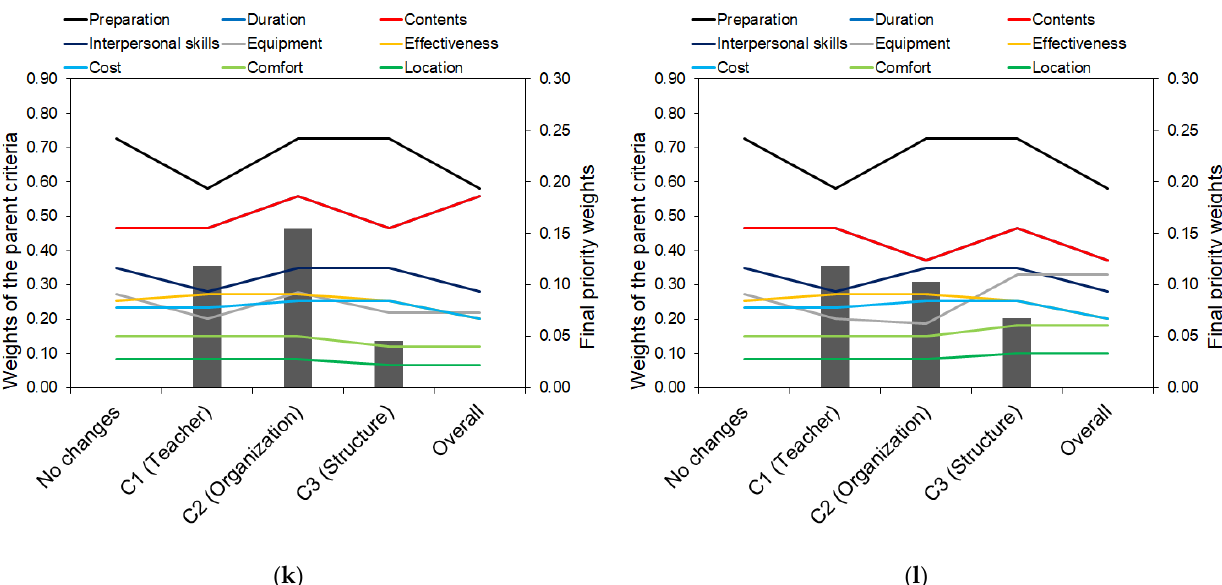
Figure 5. Simulated scenarios (according to Table 9) in the AHP sensitivity analysis: ( a ) scenario 1; ( b ) scenario 2; ( c ) scenario 3; ( d ) scenario 4; ( e ) scenario 5; ( f ) scenario 6; ( g ) scenario 7; ( h ) scenario 8; ( i ) scenario 9; ( j ) scenario 10; ( k ) scenario 11; ( l ) scenario 12. Weights of the parent criteria are represented as gray histograms and refer to the primary y -axis, while dynamical changes in the final priority weights are represented as colored straight lines and refer to the secondary y -axis. The x -axis represents five cases: original case (no changes in the parent criteria’s weights); change in the weight of only the first parent criterion (C1—teacher); change in the weight of only the second parent criterion (C2—organization); change in the weight of only the third parent criterion (C3—structure); simultaneous changes in the weights of all the parent criteria (overall). Straight lines for the “Duration” and “Contents” items appear as overlapped in all the graphs.